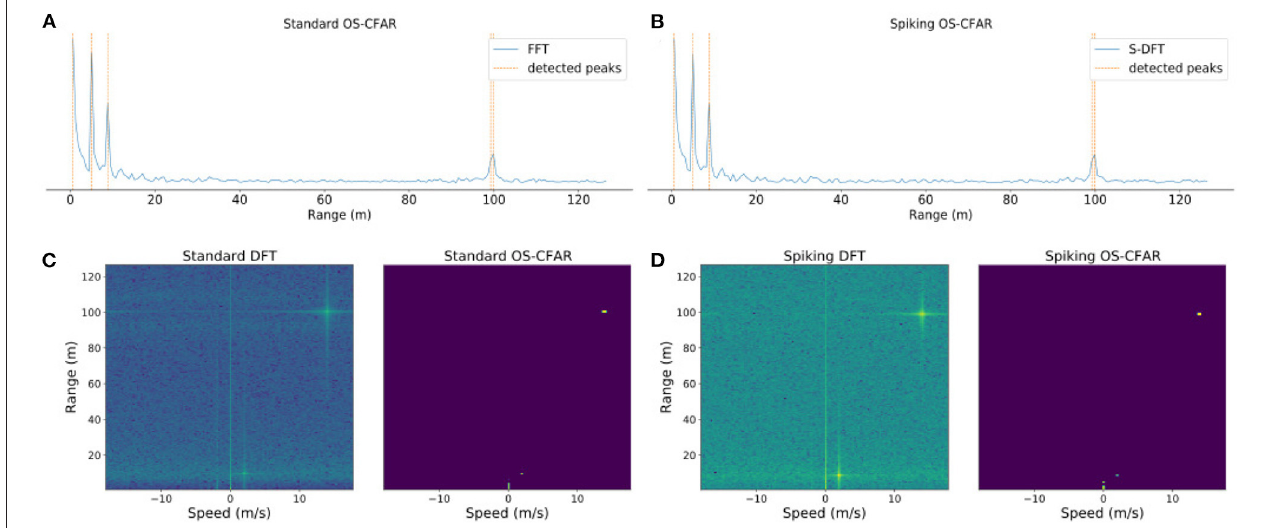
FIGURE 4 | Results of the experiments on a simulation with three targets and a car bumper next to the sensor for (A) the 1D standard DFT and OS-CFAR algorithms, (B) the 1D S-DFT and S-OSCFAR, (C) the 2D standard DFT and OS-CFAR algorithms, and (D) the 2D S-DFT and S-OSCFAR. The sensor range is up to 300 m, but for visualization purposes the range dimension has been cropped until